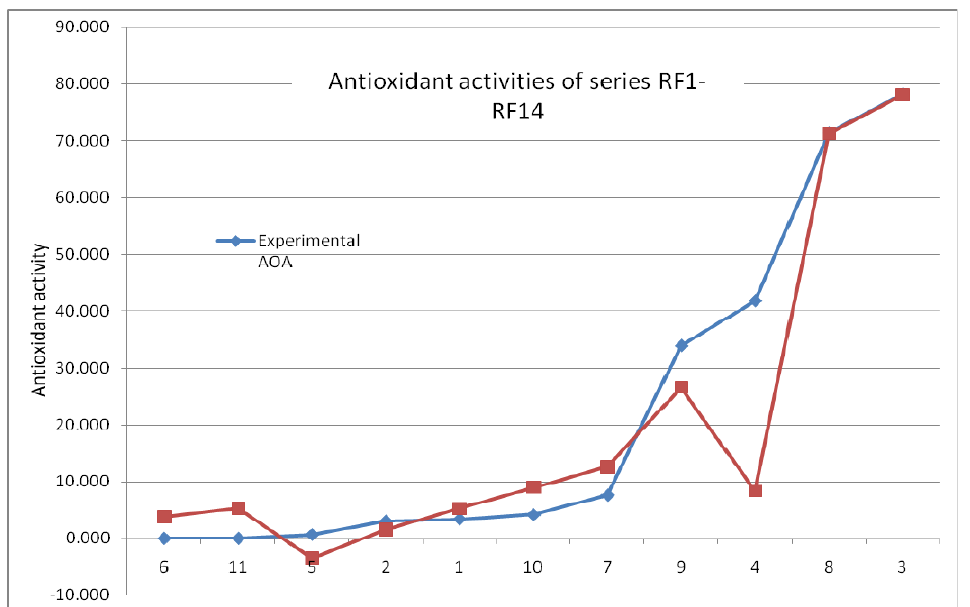
Figure 3. Comparison of experimental and calculated values of antioxidant activity (AOA) using the model from eq. 1.